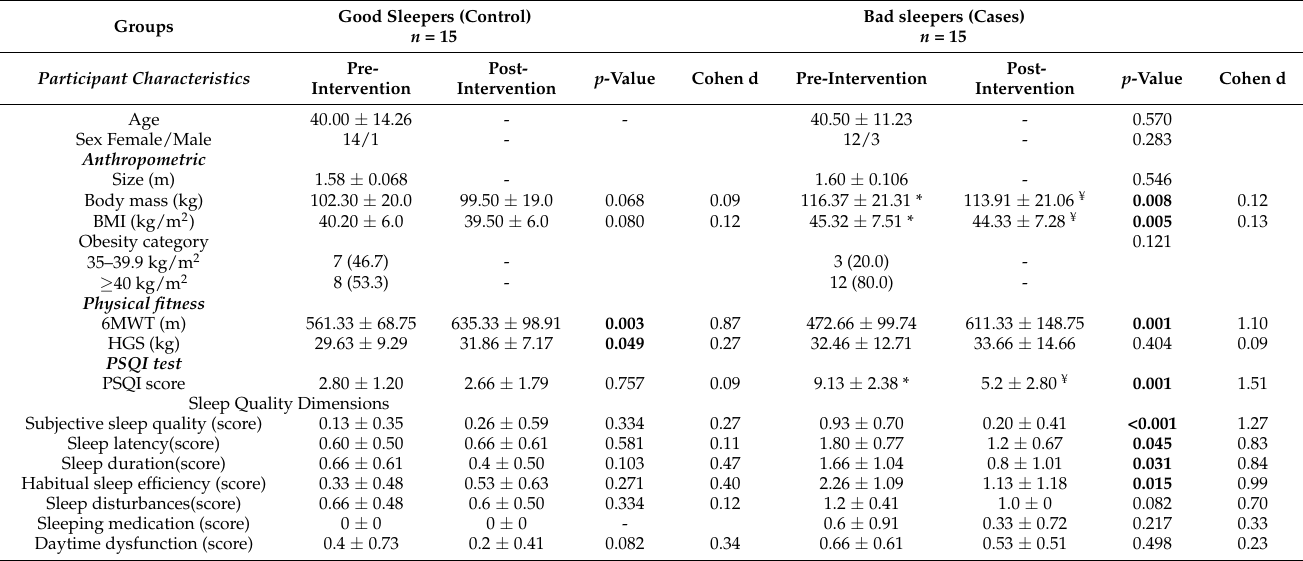
Table 2. Changes in study variables after physical activity